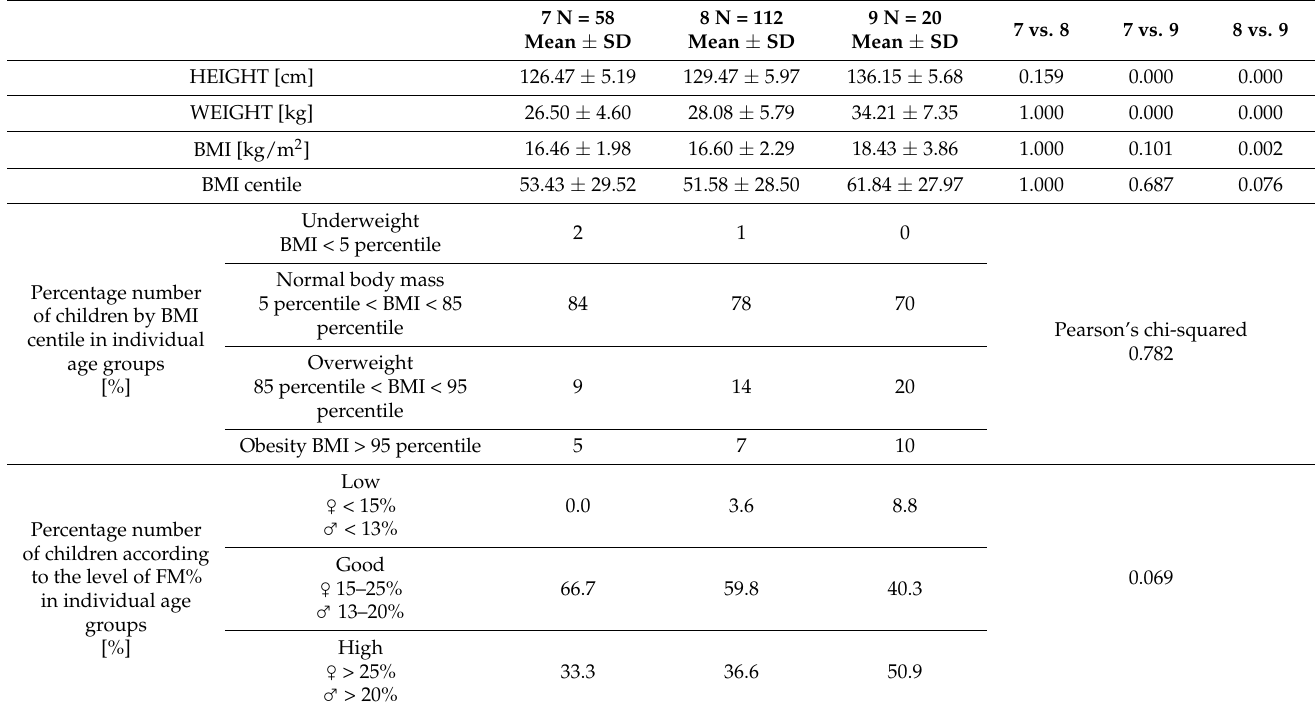
Table 1. Anthropometric data of the participants by age group.